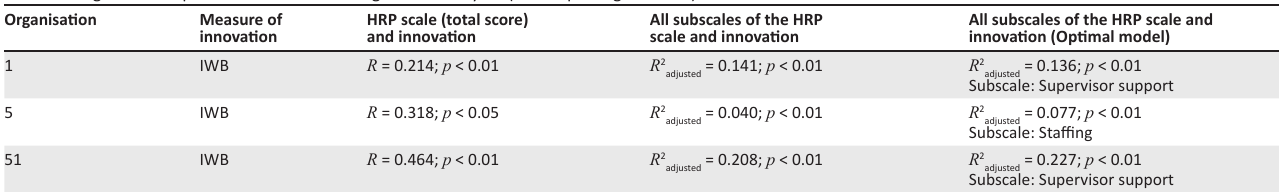
All subscales of the HRP scale and